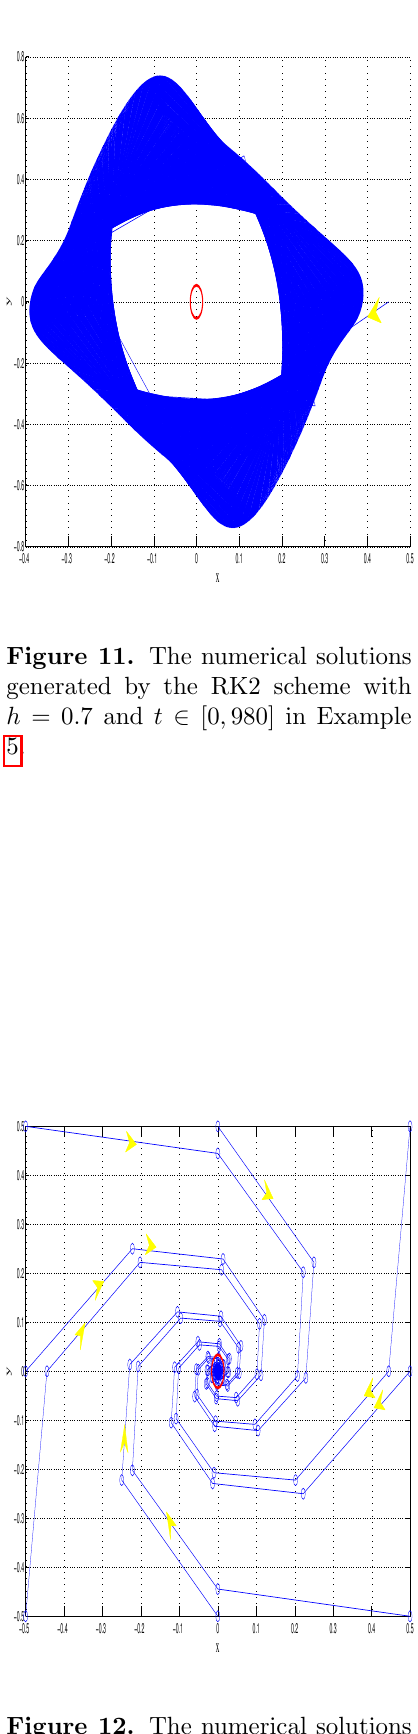
Figure 10. The numerical solution generated by the Euler scheme with h = 0 . 4 and t ∈ [0 , 1000] in Example 5.